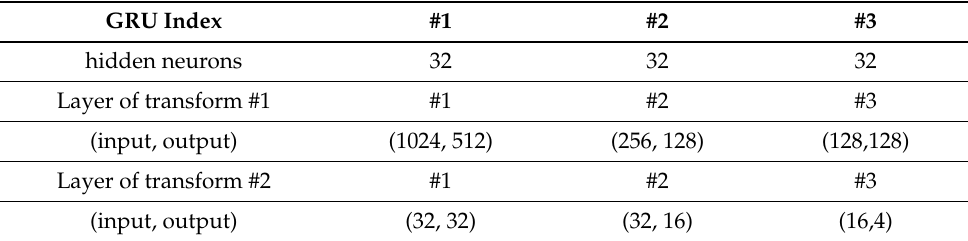
Table 1. Network structure